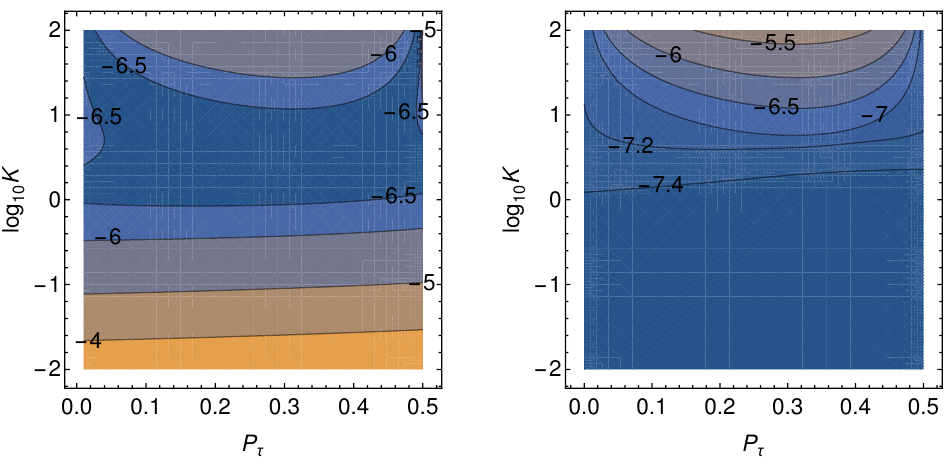
Figure 2 . Required log j (cid:14)(cid:15) j for the aligned case (cid:14)(cid:15) e = (cid:14)(cid:15) for zero (left) and thermal (right) initial 10 N 1 abundance to explain the observed baryon